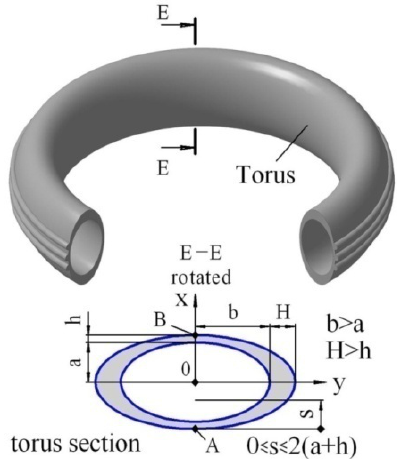
Figure 7. Elastic chamber (¼ section) in the shape of a torus and its